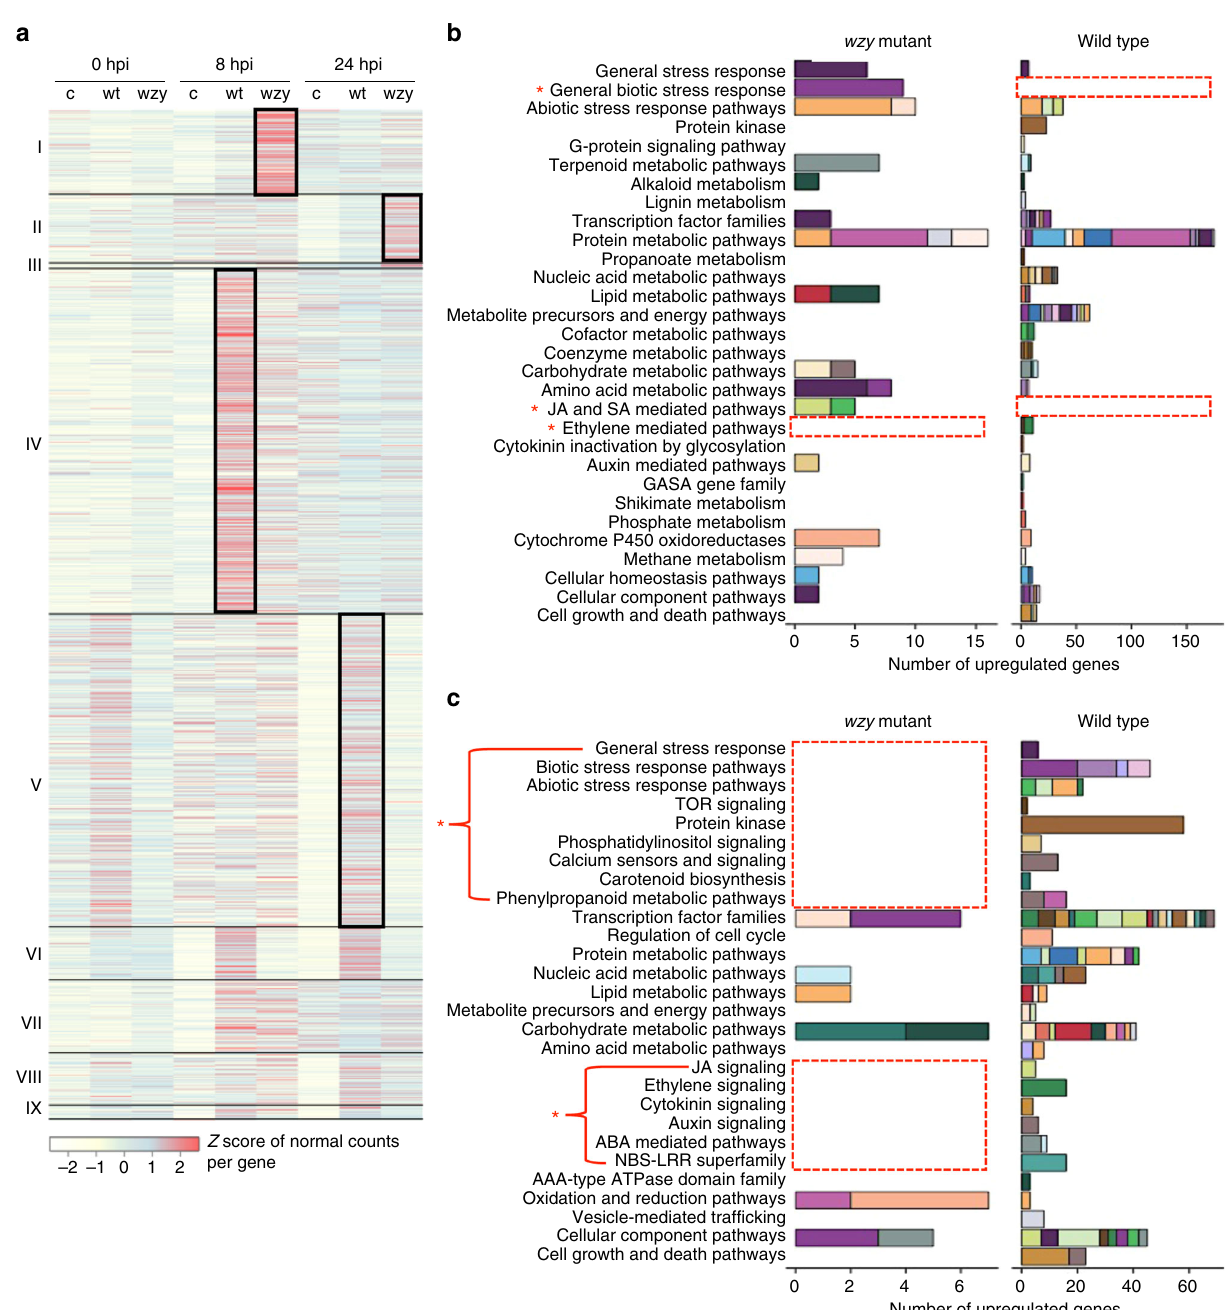
Fig. 3 Grapevine responses to early infection by wzy mutant or wild type Xf . a Upregulated grape genes ( P < 0.05) in response to wzy mutant (wzy) or wild type (wt) bacteria at 8 and 24 h post-inoculation (hpi) when compared to 1× PBS controls (c). Genes are classi fi ed into nine groups (I – IX) based on their expression pattern. The colors in the heat map represent the Z score of the normal counts per gene, and black boxes represent gene groups distinctly upregulated in response to each treatment and time point. b Enriched grape functional pathways ( P < 0.05, hypergeometric test, n = 3 per treatment) among genes upregulated during wzy (group I) or wt (group IV) infections at 8 h. c Enriched grape functional subcategories ( P < 0.05, hypergeometric test, n = 3 per treatment) among genes upregulated during wzy (group II) or wt (group V) infections at 24 h. Colored stacked bars represent individual pathways. Red boxes highlight functions of interest (*) that are enriched in one treatment, but not enriched in the other at each time point. The complete dataset, including the color legend for each pathway, is available in Supplementary Data vascular pathogens 4,32 . Their functions include speci fi c roles in defense against pathogen infection, such as enhanced production of ROS (as signal mediators and antimicrobial agents) and enhanced production of phytoalexins 33 . The upregulation of these peroxidase genes corroborates our phenotypic data of an enhanced and dynamically different production of ROS in the